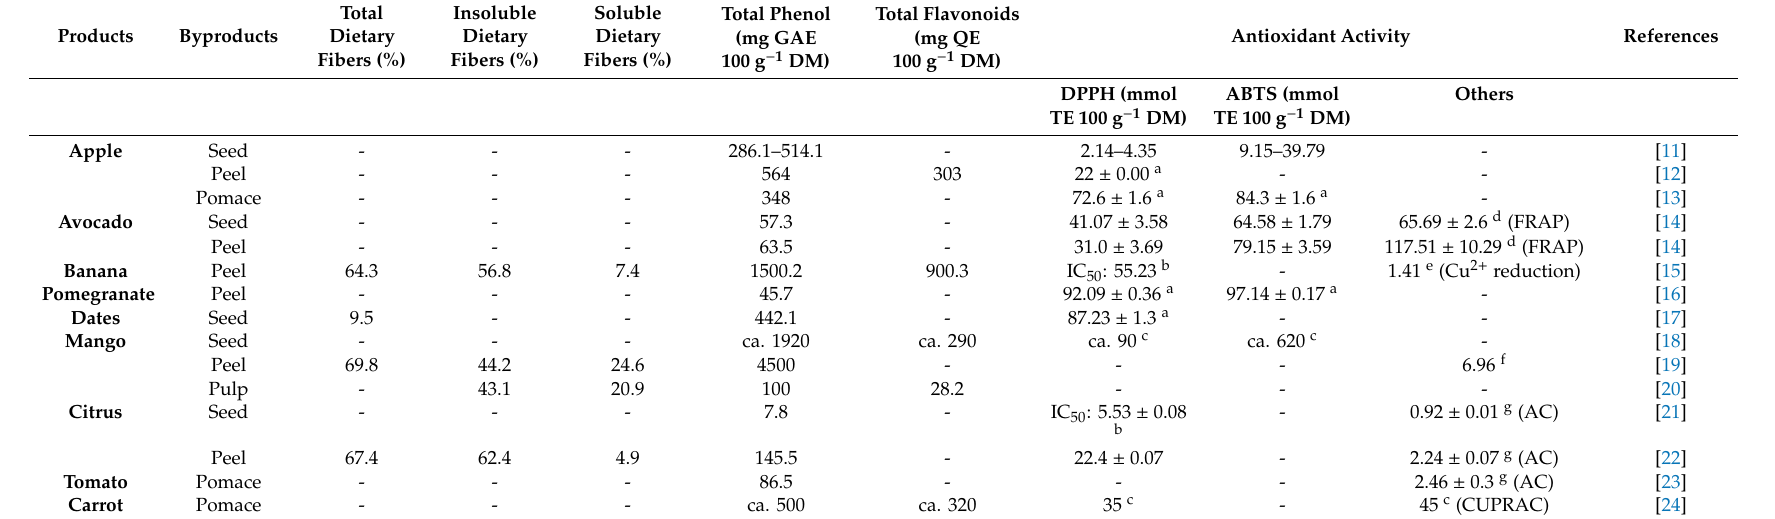
Table 1. Dietary fibers, total phenols and total flavonoids in industrial fruit and vegetable byproducts and their antioxidant activity.